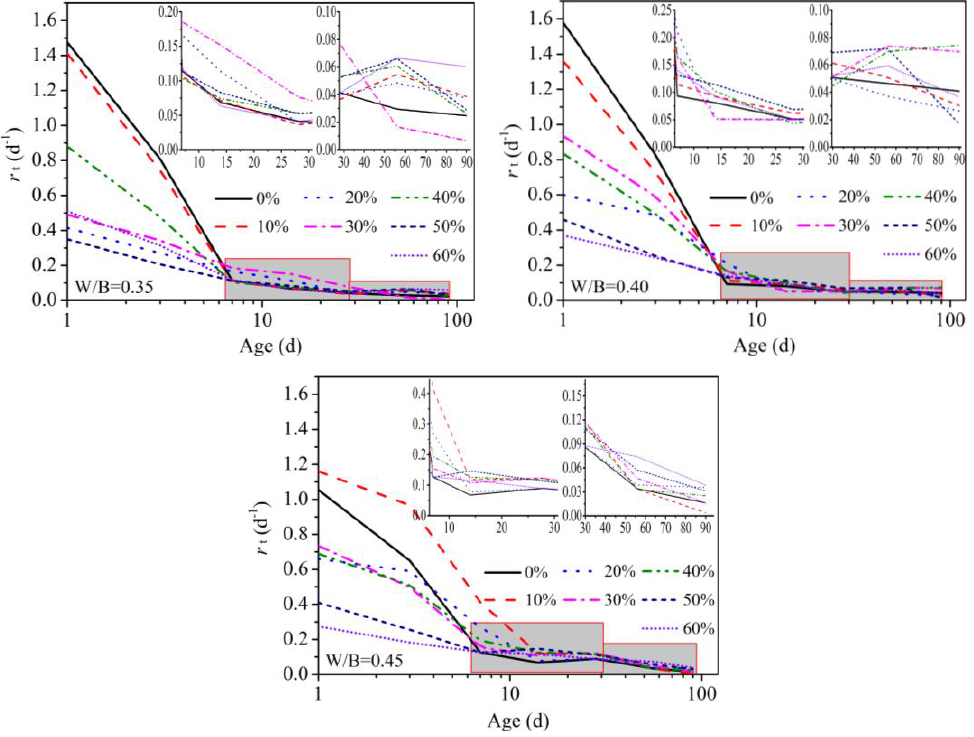
Figure 5. Hydration rate of the sample.